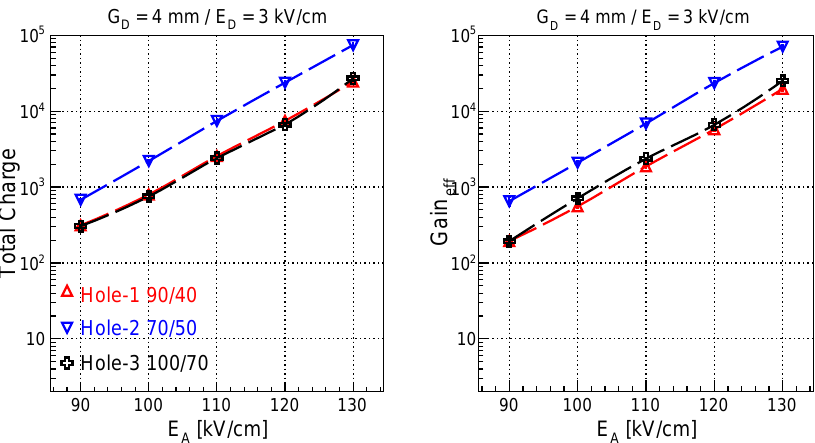
Figure 7. Total charge ( left ) and effective gain ( right ) vs. E A . Hole-2 configuration leads to higher gains.